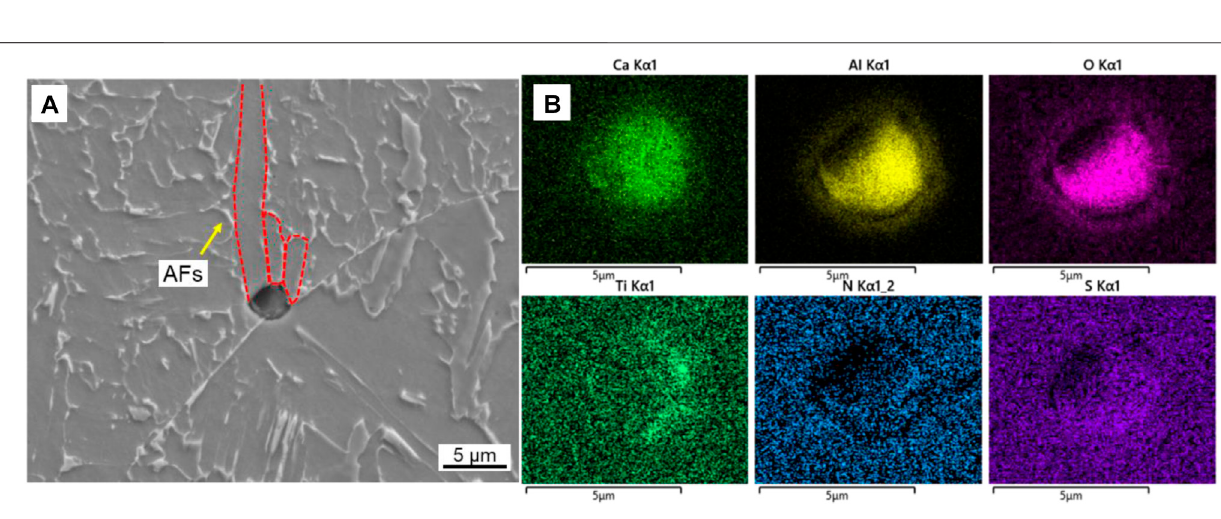
Frontiers in Materials |